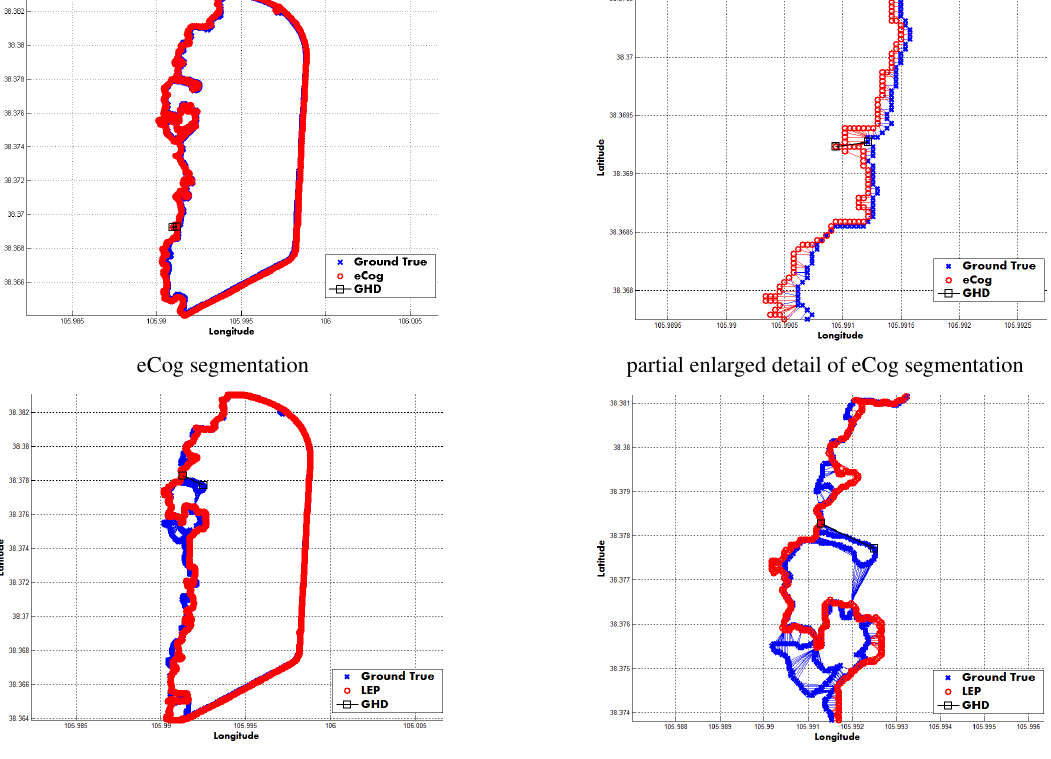
Figure 3: Detailed segmentation result of eCog and LEP with the GHD value of 0.024908 Km and 0.12825 Km respectively